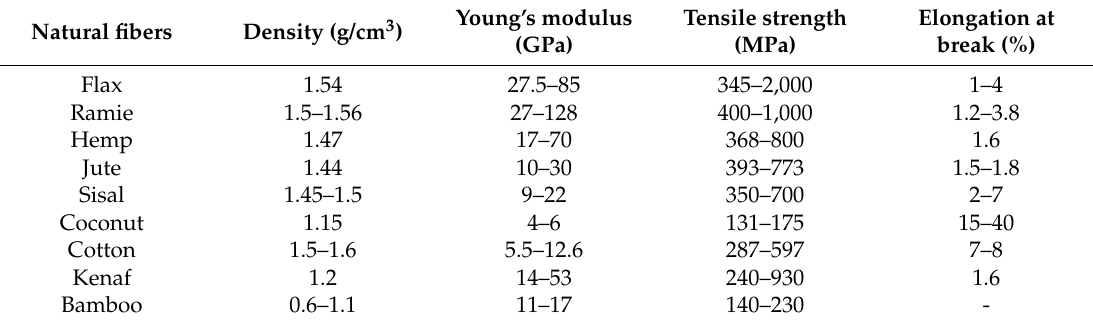
Table 1. Mechanical properties of some natural fibers